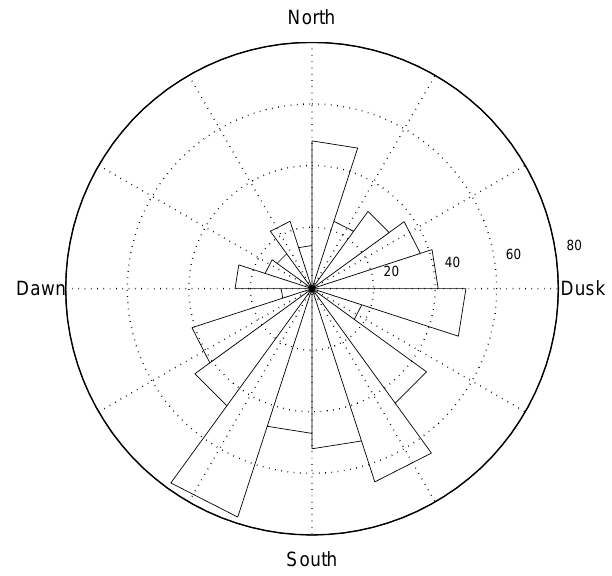
Fig. 4. The IMF clock angle distribution for all events simulated with GUMICS-4, listed in Table 1. The bar size indicates the num- ber of time instants during the simulations during which the clock angle was in the specified direction in GSM coordinate system. North is at the top, dusk to the right, south at the bottom, and dawn to the